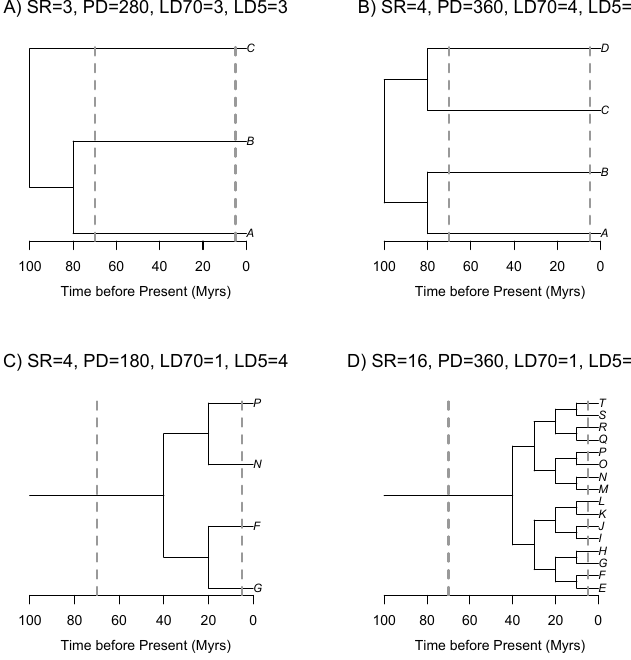
Figure 1. Example phylogenies for four mock assemblages ( A – D ) with contrasting species richness (SR), phylogenetic diversity (PD) and phylogenetic structure (LD70 = number of lineages 70 Ma; LD5 = number of lineages 5